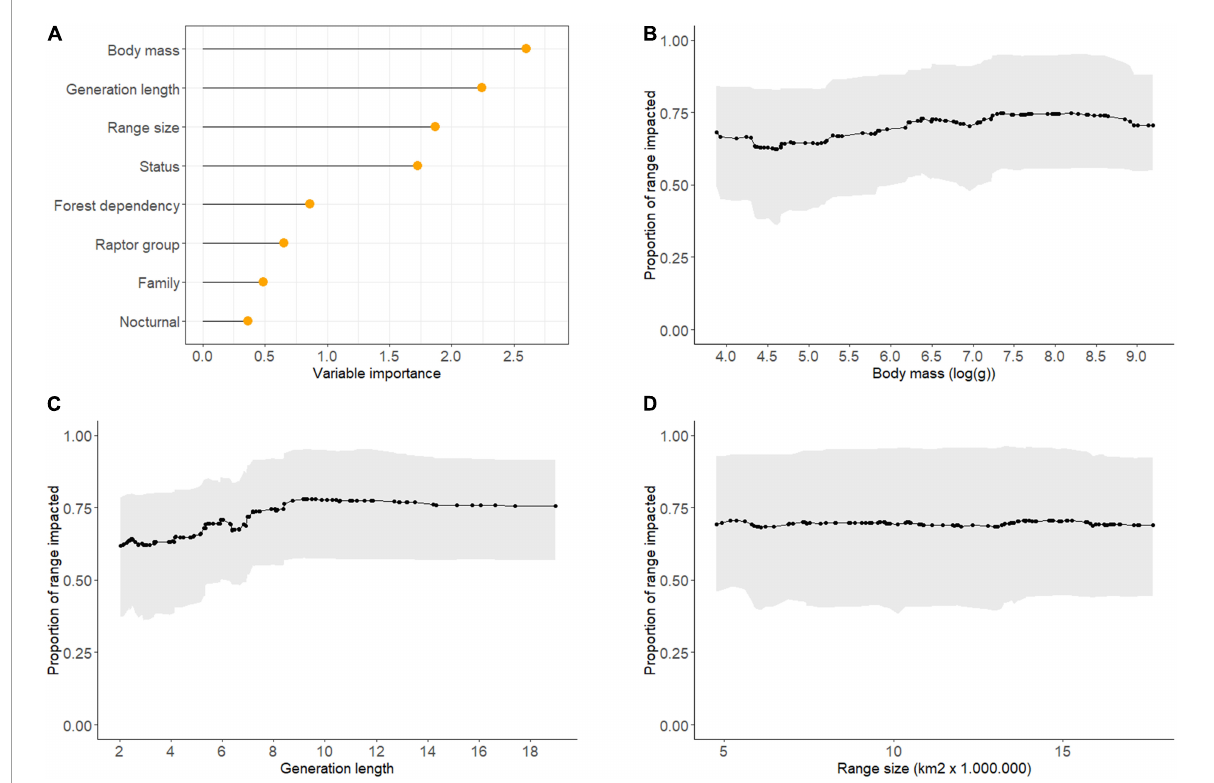
FIGURE3 The relative importance of each variable in the random forest model at predicting the proportion of a species range impacted by threats (A) , and partial dependence plots of the strongest predictors including; body mass (B) , generation length (C) , and range size (D) . The gray shaded areas in (B–D) represent 95% confidence